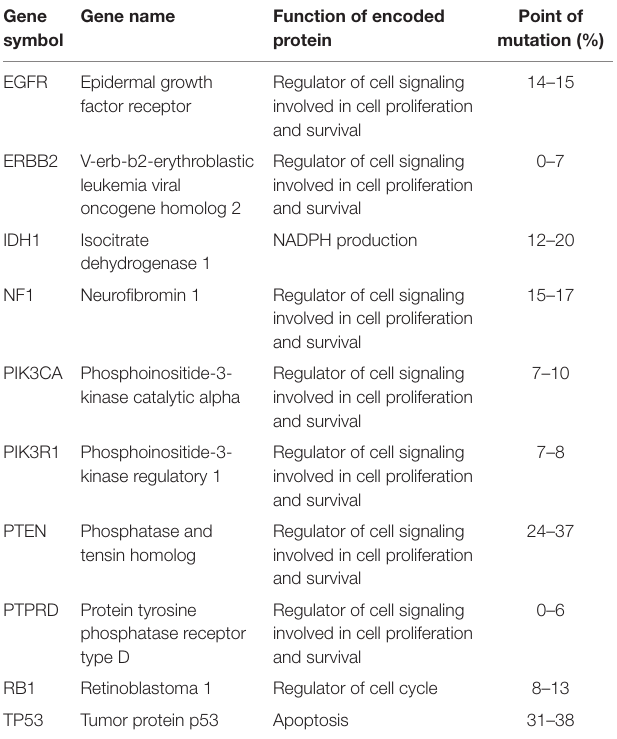
TABLe 1 | Genes commonly mutated in